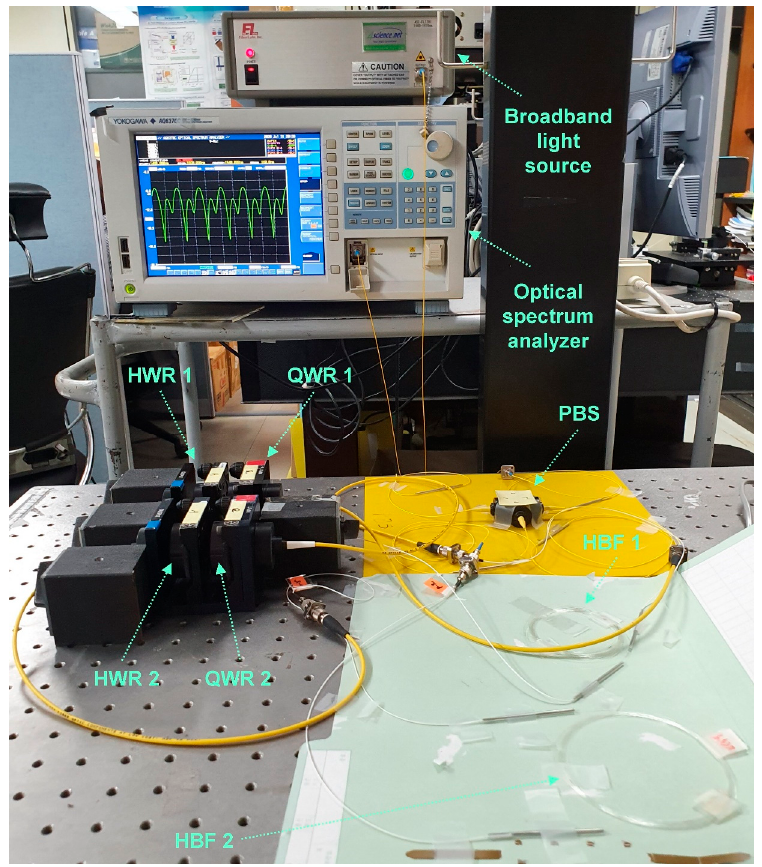
Figure 4. Actual experimental setup for measurement of transmission spectra of the constructed filter.